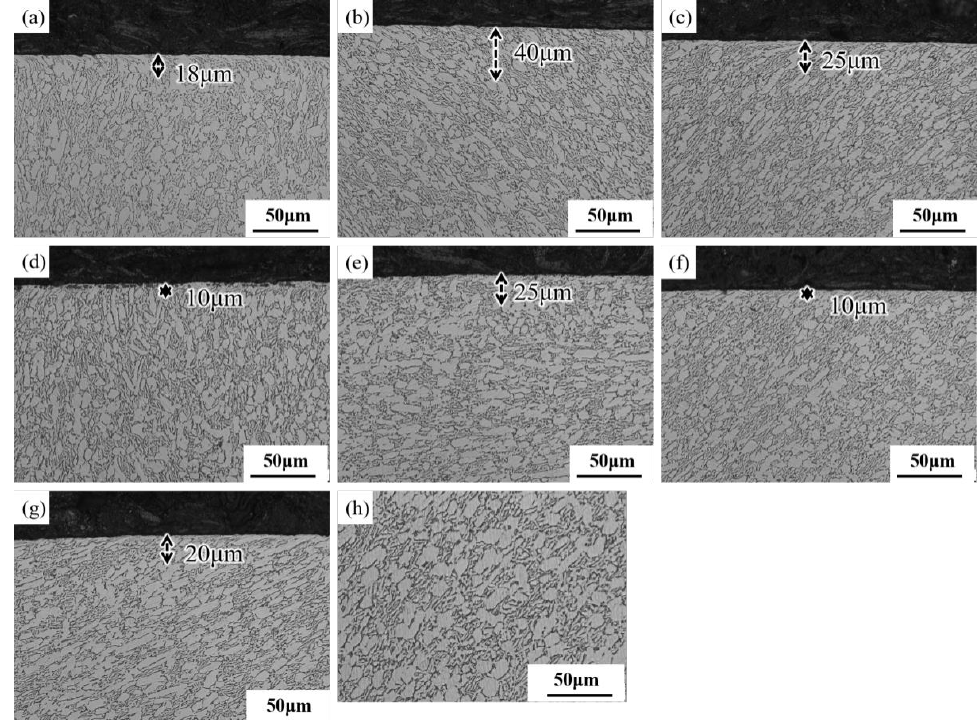
Figure 8. Microstructural changes under different surface ultrasonic rolling processes. ( a – g ) SUR 1 – SUR 7, ( h ) original microstructure.